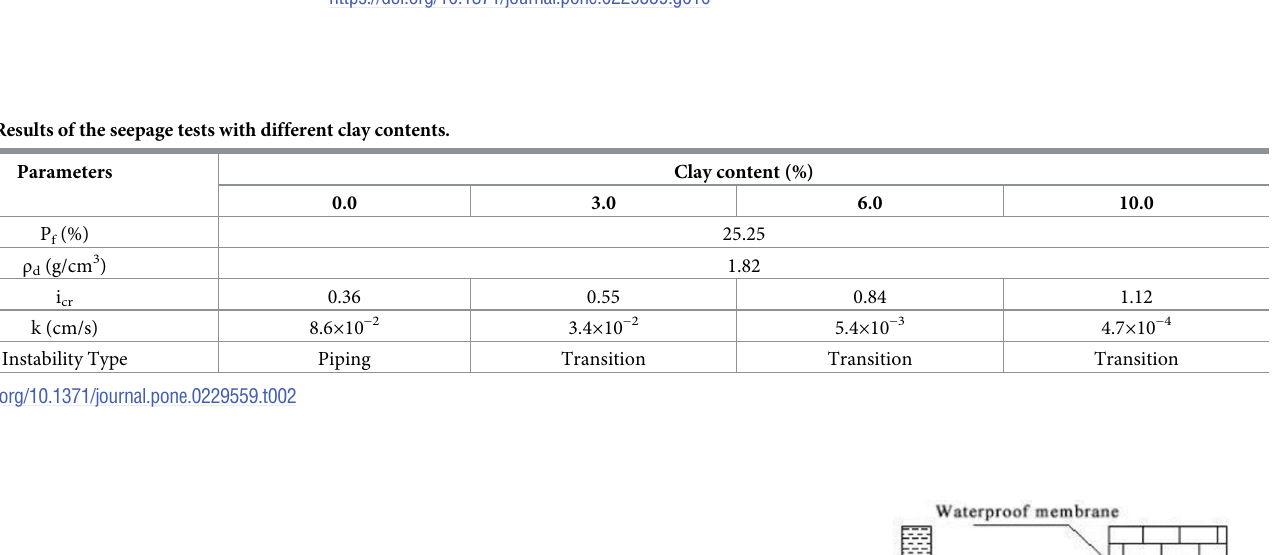
Fig 10. The relationship between the hydraulic gradient and the seepage velocity for specimens with different clay contents.